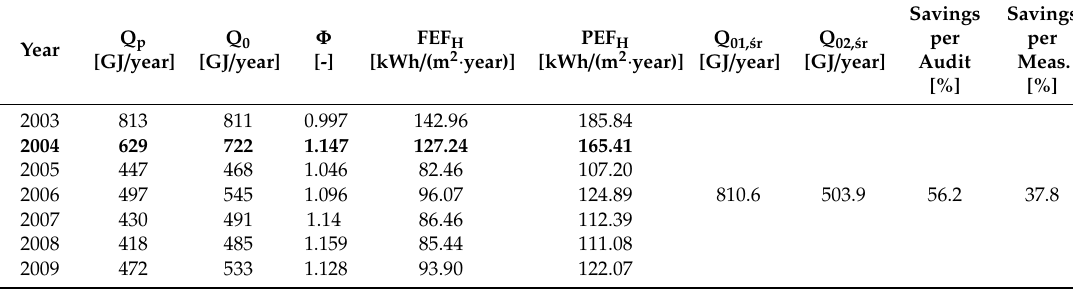
Table 5. Characteristics and heat consumption of an object from the group